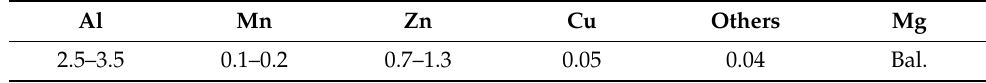
Table 1. Chemical composition of AZ91D magnesium